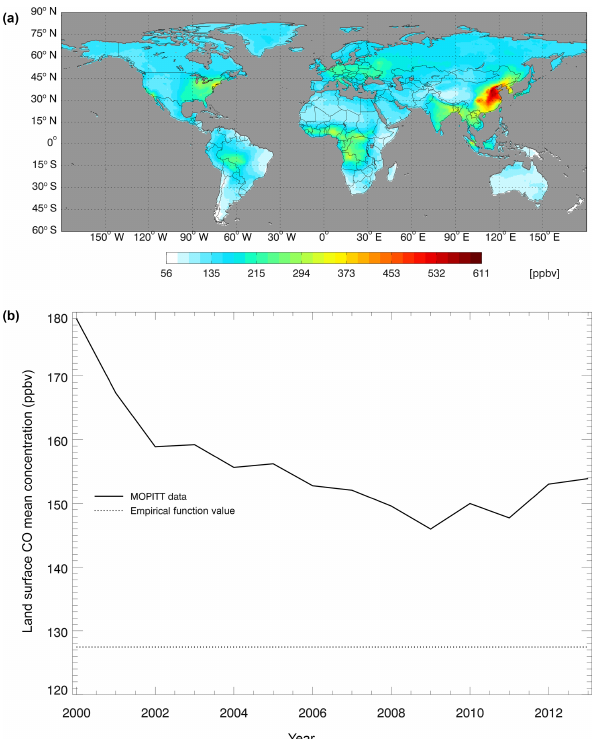
Figure 5. CO surface concentration data from the MOPITT satellite (ppbv): (a) the global mean CO surface concentrations from MO- PITT during 2000–2013; (b) the CO annual surface concentrations from both MOPITT and empirical functions (Potter et al.,